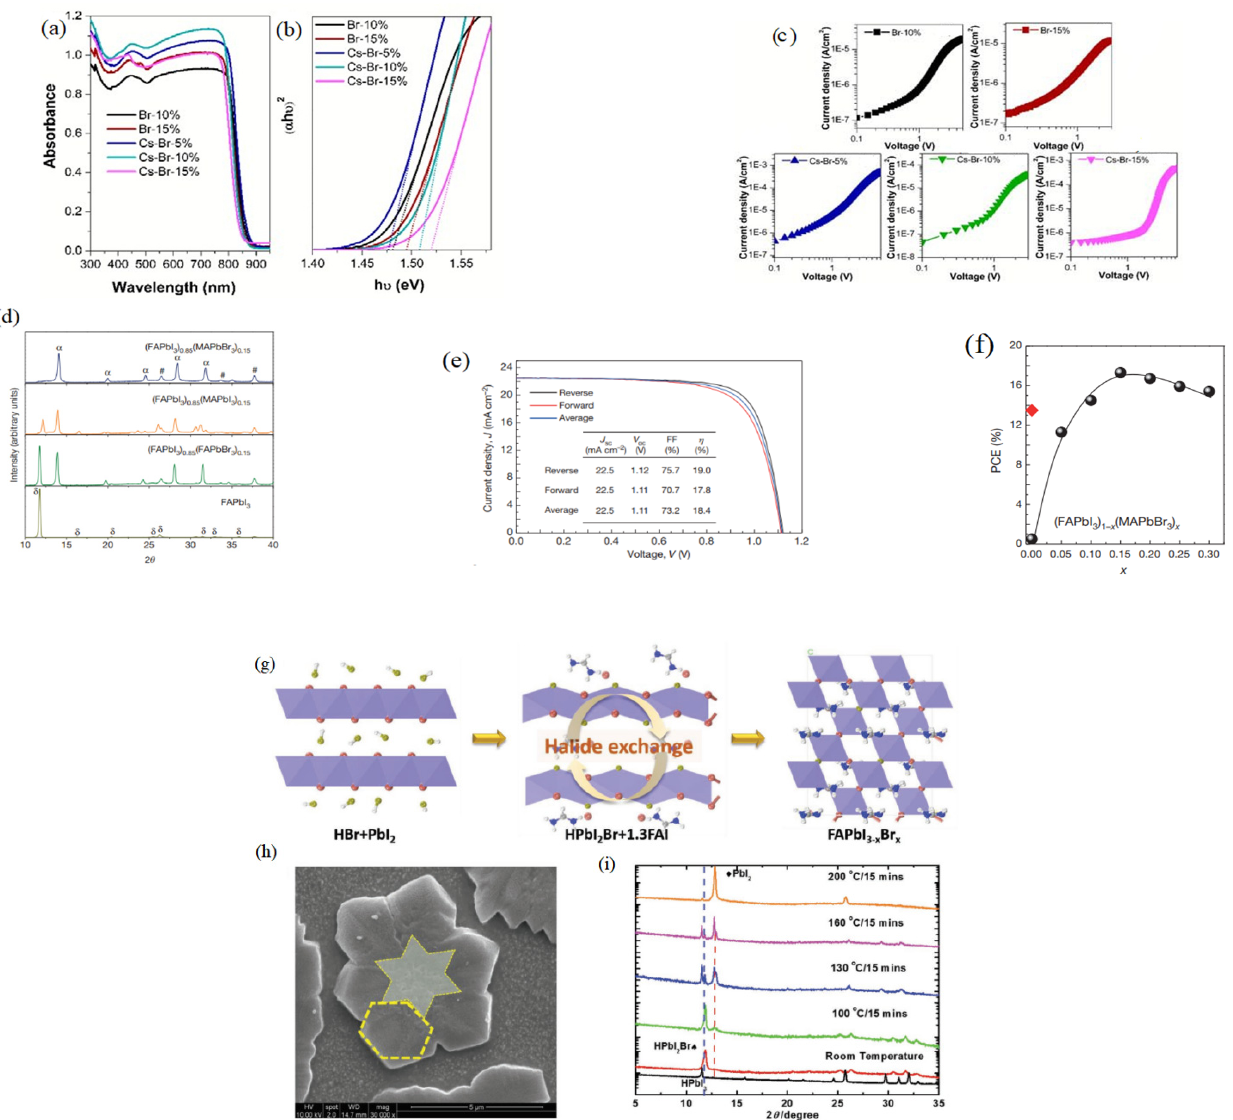
Figure 3. ( a ) Absorbance spectra of stable FA-based halide perovskite and Tauc plot ( b ); ( c ) The I-V curves of doped formamidinium-lead-halide-based hole-only devices with the different structures (Reprinted with permission from Ref. [46]. Copyright 2018 Royal Society of Chemistry). ( d ) XRD spectra of four FA-based perovskites annealed at 100 °C for 10 min; ( e ) The red line and the black line indicated PCE values of pure FAPbI 3 and (FAPbI 3 ) 1 − x (MAPbBr 3 ) x annealed at different temperature (100 °C, 150 °C), respectively. And then the α -phase was formed; ( f ) J–V curves of (FAPbI 3 ) 0.85 (MAPbBr 3 ) 0.15 perovskite material. (Reprinted with permission from Ref. [47]. Copyright 2015 Nature). ( g ) Schematic diagram of intermediate synthesis of HPbI 2 Br and its halide exchange pro- cessing; ( h ) SEM of HPbI 2 Br; ( i ) XRD spectra of HPbI 2 Br material at different temperature. Reprinted with permission from Ref. [48]. Copyright 2017 WILEY-VCH Verlag GmbH & Co. KGaA,